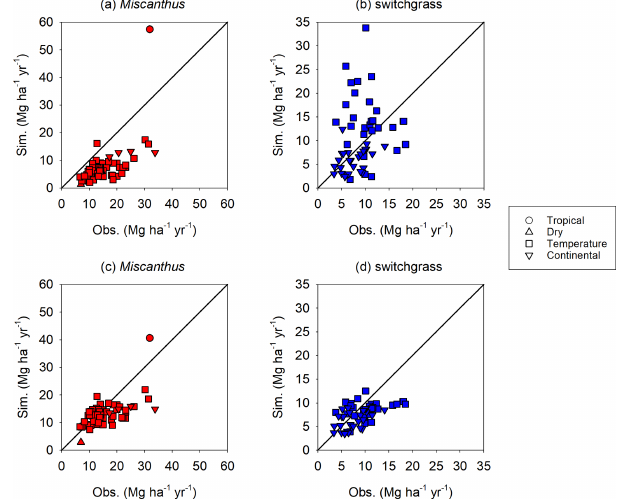
Figure 4. Overall comparison of the simulated (Sim.) and observed (Obs.) yields for Miscanthus and switchgrass. The simulated yields in (a) and (b) are from the original H08 model, whereas those in (c) and (d) are from the enhanced H08 model. The black line is the 1 : 1